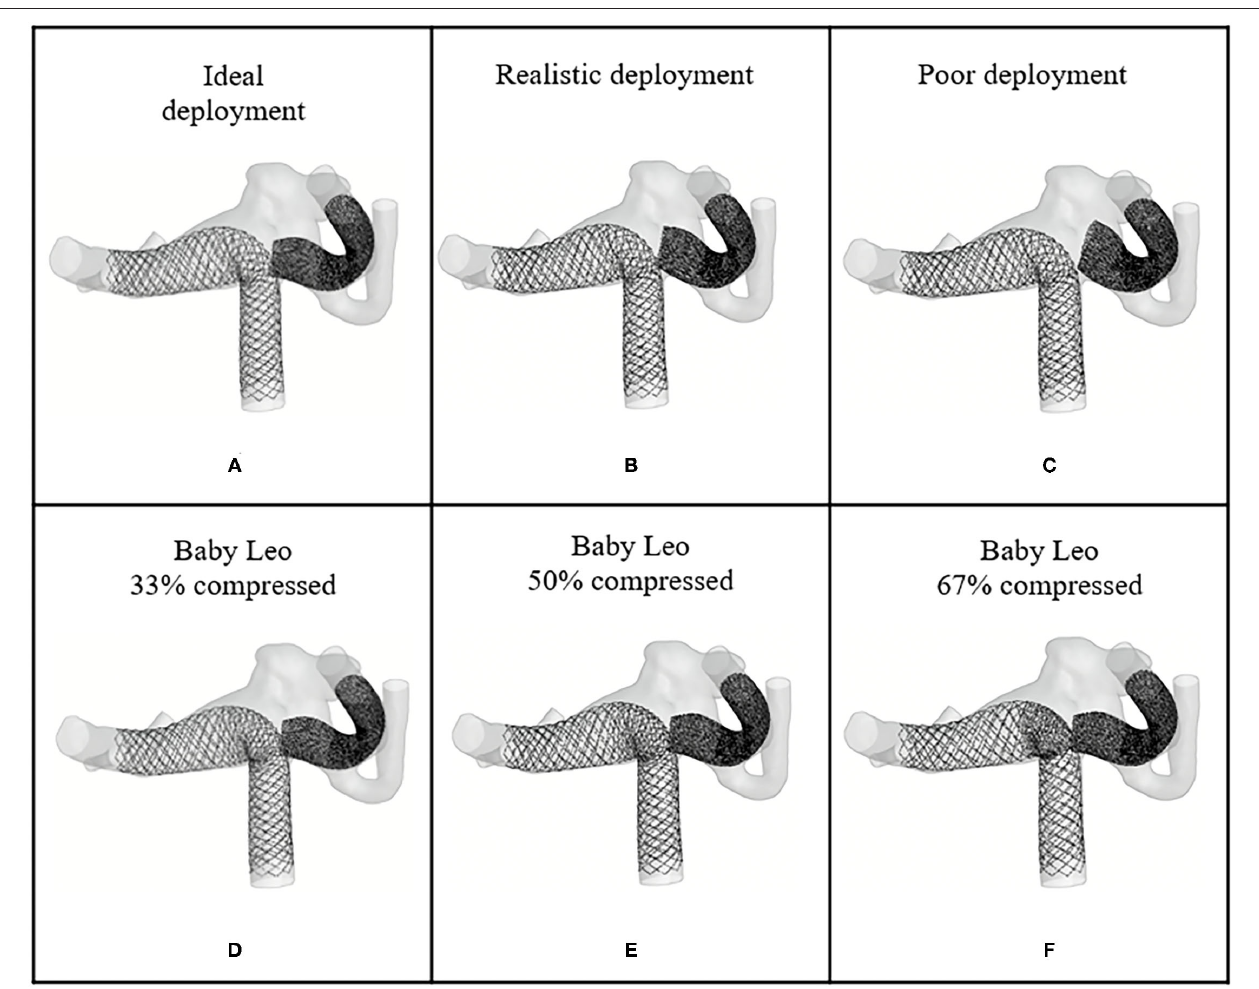
FIGURE 5 | Deployed device positions in WNBA II. (A) Ideal deployment of SVB in the side daughter vessel. (B) Realistic deployment of SVB in the side daughter vessel. (C) Poor deployment of SVB in the side daughter vessel. (D–F) The deployment of BABY LEO with 33, 50, 67% compression rate in the mid third part of the